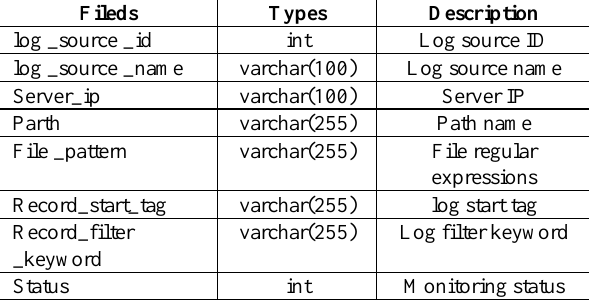
Table 1. Log source datasheet design